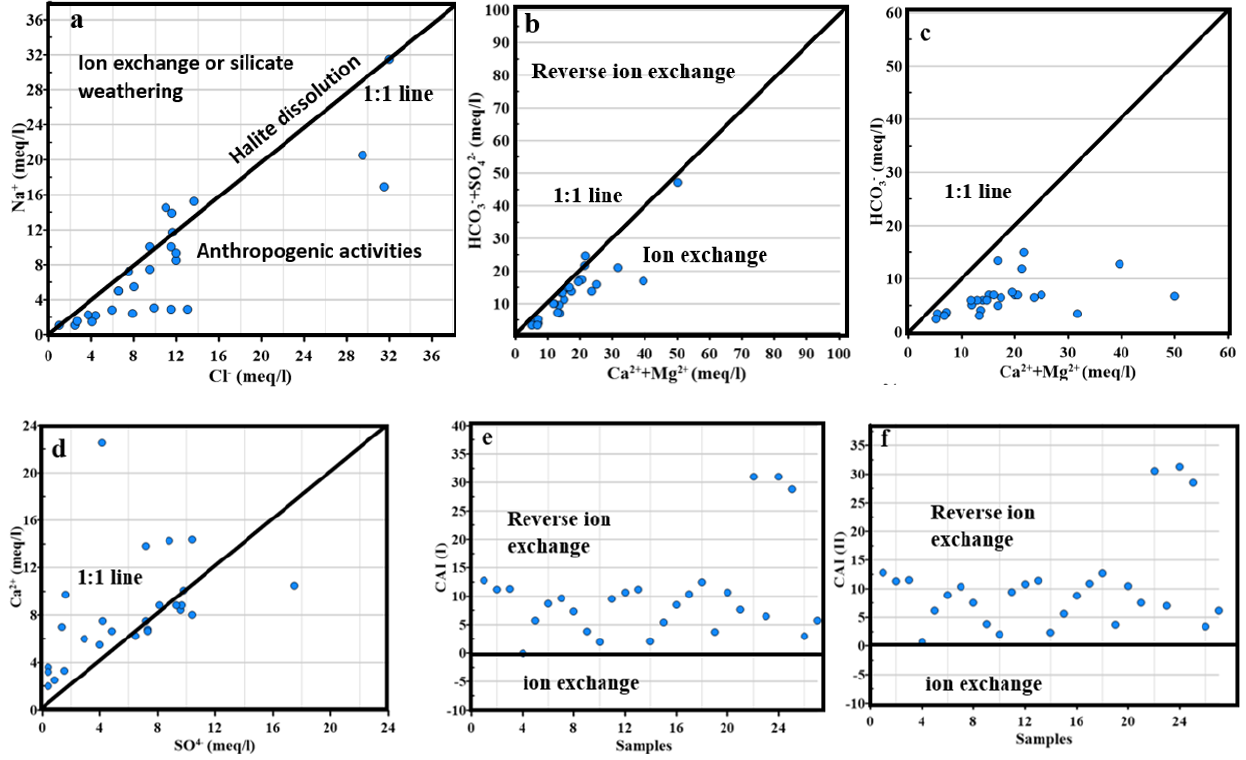
Figure 10. Relationships between the main cations and anions in the sample water using stoichiom- etry: ( a ) Na + vs. Cl − , ( b ) Ca 2+ + Mg 2+ vs. HCO 3 − + SO 42 − , ( c ) Ca 2+ + Mg 2+ vs. HCO 3 ̶ , ( d ) Ca 2+ vs. SO 42 − , ( e ) Samples vs. CAI-I, and ( f ) Samples vs. CAI-II.